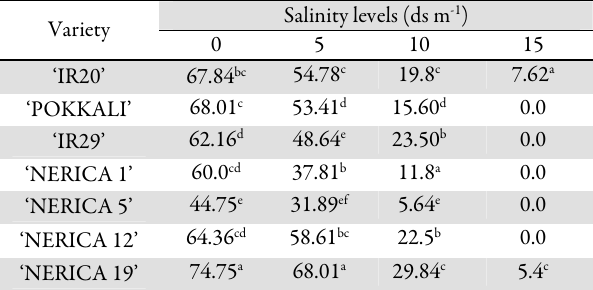
Tab. 3. Effect of salinity on Germination Energy (GE %) of different rice